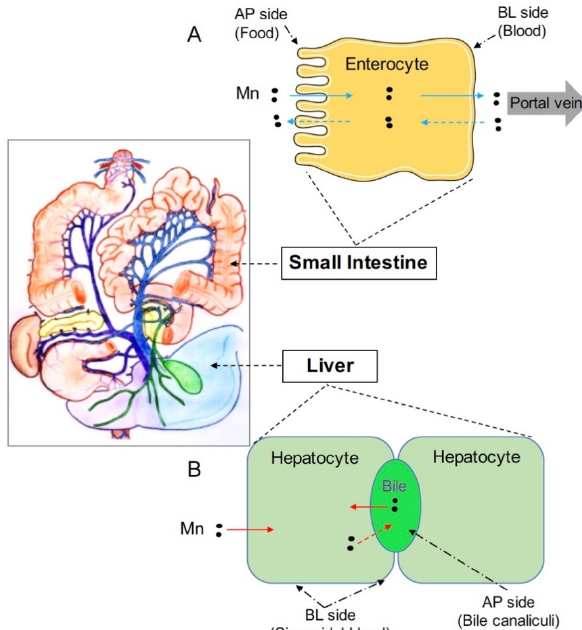
Figure 1. Both the intestine and liver play important roles in regulating systemic manganese metabolism. ( A ) Enterocytes are absorptive cells lining the lumen of intestine. Digested manganese (Mn) in the intestinal lumen can be transported across the apical (AP) membrane into enterocytes and exported across the basolateral (BL) membrane into the blood (solid blue arrows). Absorbed Mn will then be delivered to the liver through the portal vein. Mn in the blood can also be transported into enterocytes and exported back into the intestinal lumen (dashed blue arrows); ( B ) The liver clears Mn from the blood and secretes Mn into the bile for intestinal reabsorption or fecal excretion. Hepatocytes are polarized and represent the major cell type in the liver. The basal domain of hepatocytes faces the sinusoid blood; whereas, the apical domain forms the bile canalicular network. Hepatocytes express polarized, specific transporters that mediate manganese fluxes into or out of these cells (solid red arrows: manganese transport into hepatocytes from the blood or the bile; dashed red arrow: manganese export from hepatocytes into the bile).